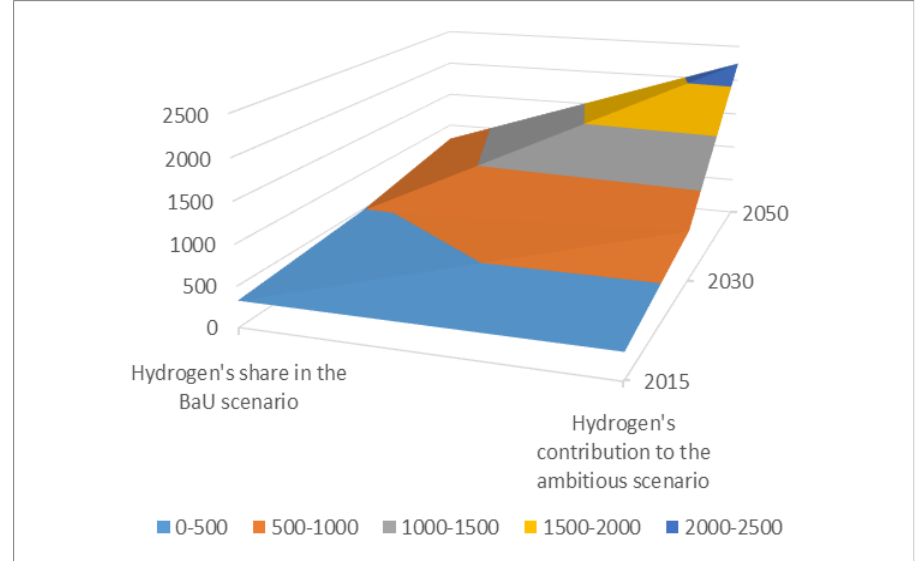
Figure 5. Final energy requirement from hydrogen in TWh [57].